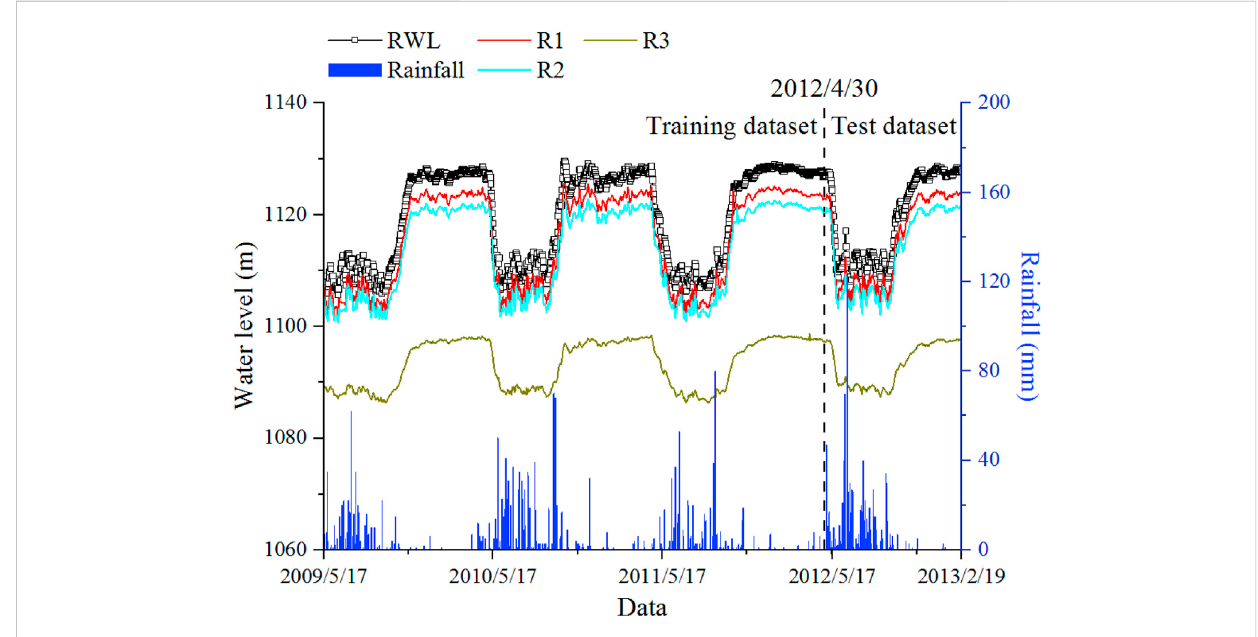
FIGURE 8 Time series of monitoring